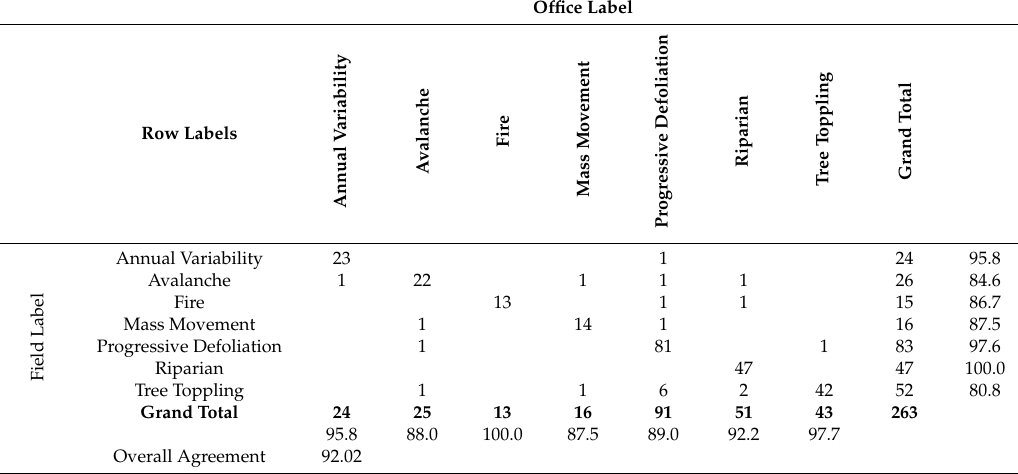
Table 4. Agreement matrix comparing primary labels assigned in office and field for both random and incidental samples.